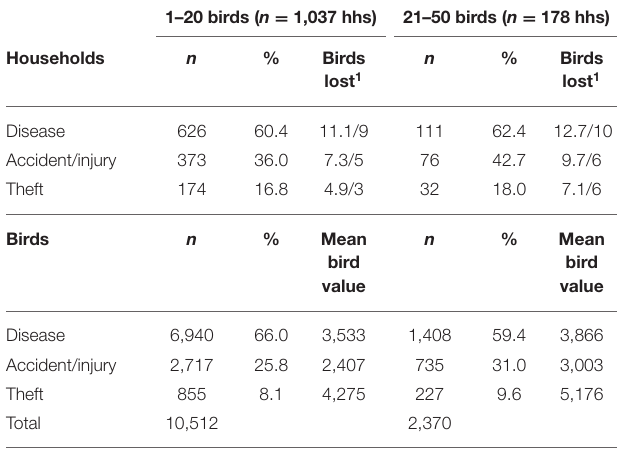
TABLE 4 | Number and proportion of households (hhs) experiencing bird losses and number of birds lost by cause in flocks of 1–20 and 21–50 birds (upper panel), and number, proportion and median value of birds lost by cause in flocks of 1–20 and 21–50 birds (lower panel). 1–20 birds ( n = 1,037 hhs)